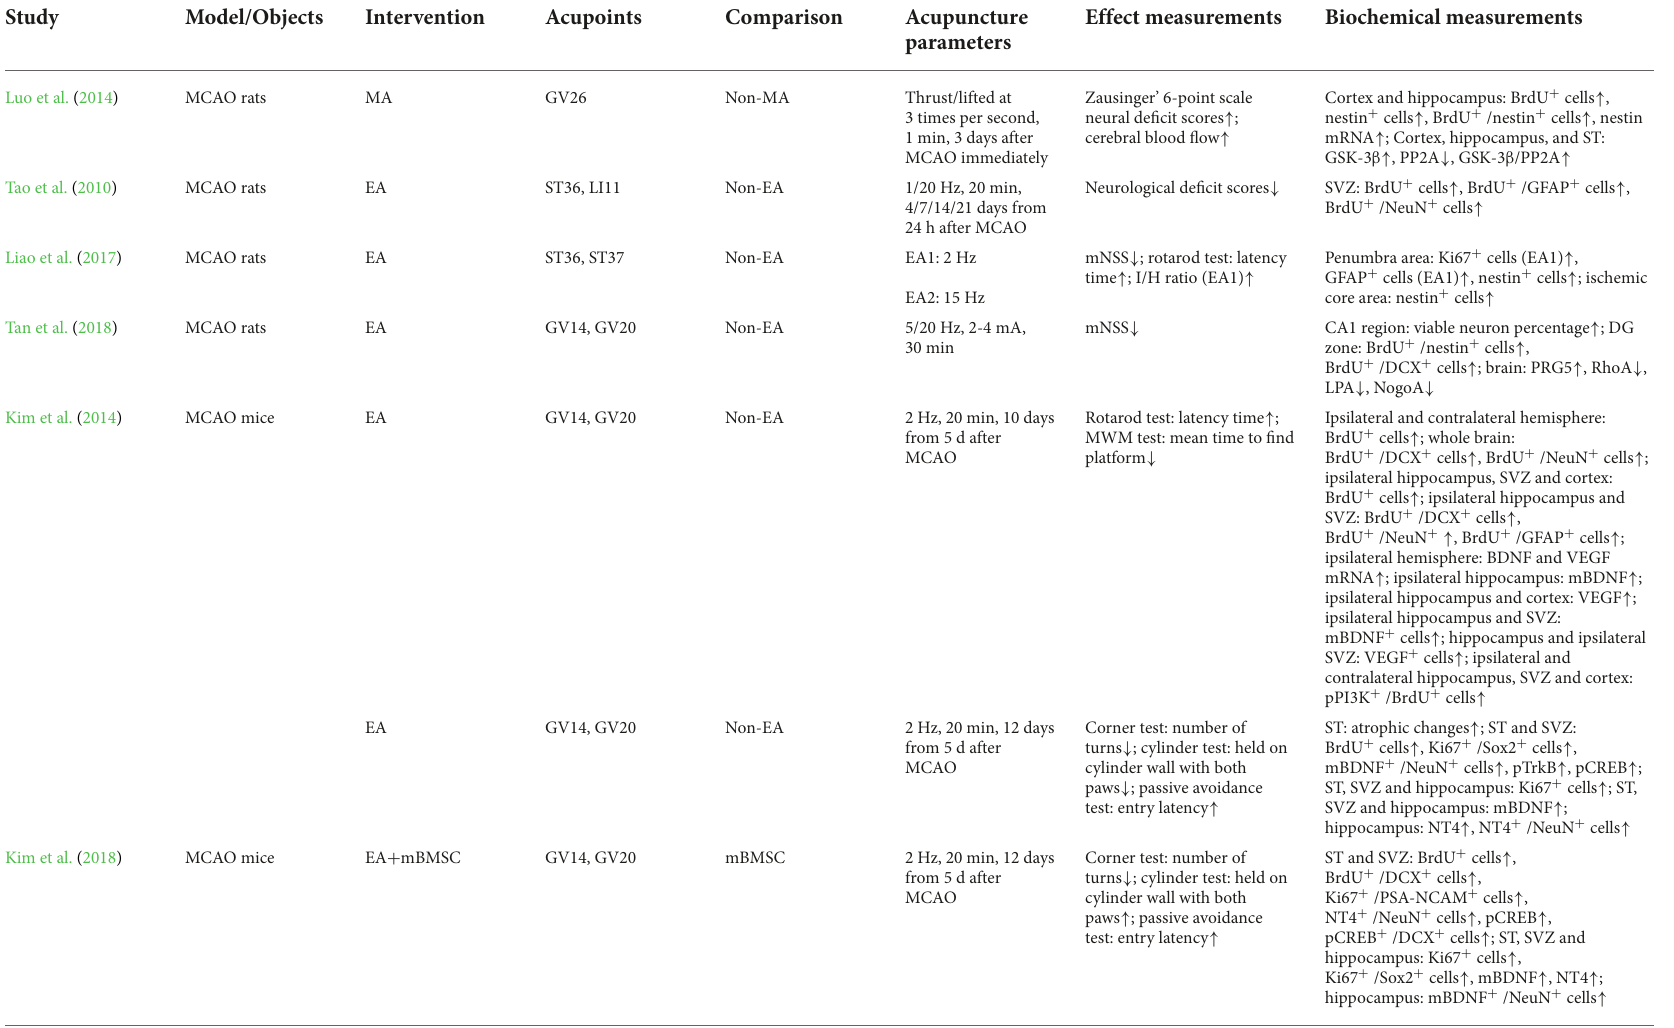
TABLE 1 The mechanisms of acupuncture on regulating neuroplasticity in the treatment of ischemic